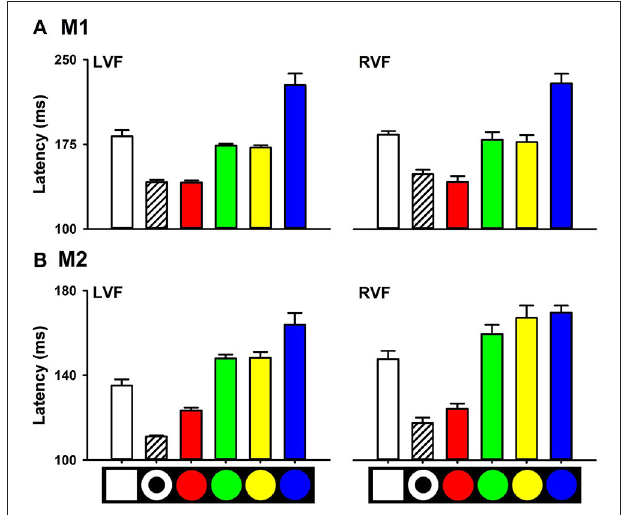
FIGURE 4 | Saccade latencies to targets with different colors (A) , M1; (B) , M2.